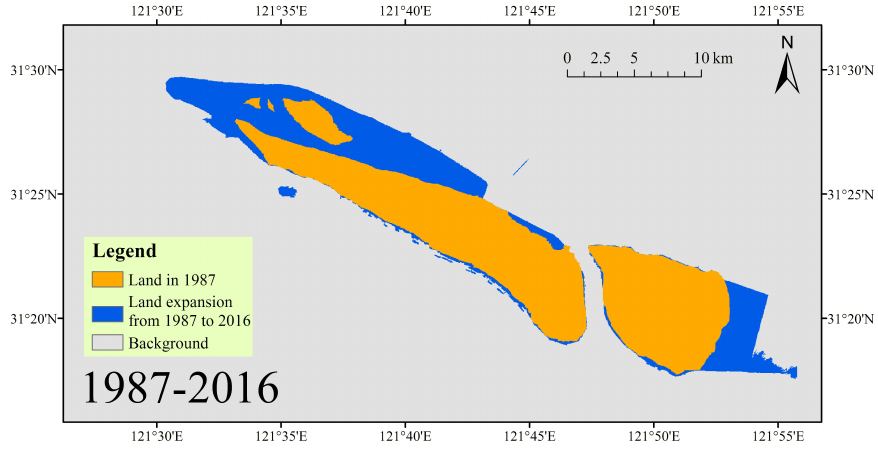
Figure 8. Change in the area of the estuarine islands between 1987 and 2016. The blue areas indicate land expansion from 1987 to 2016. Background represents the unchanged ocean area in 1987 and 2016.